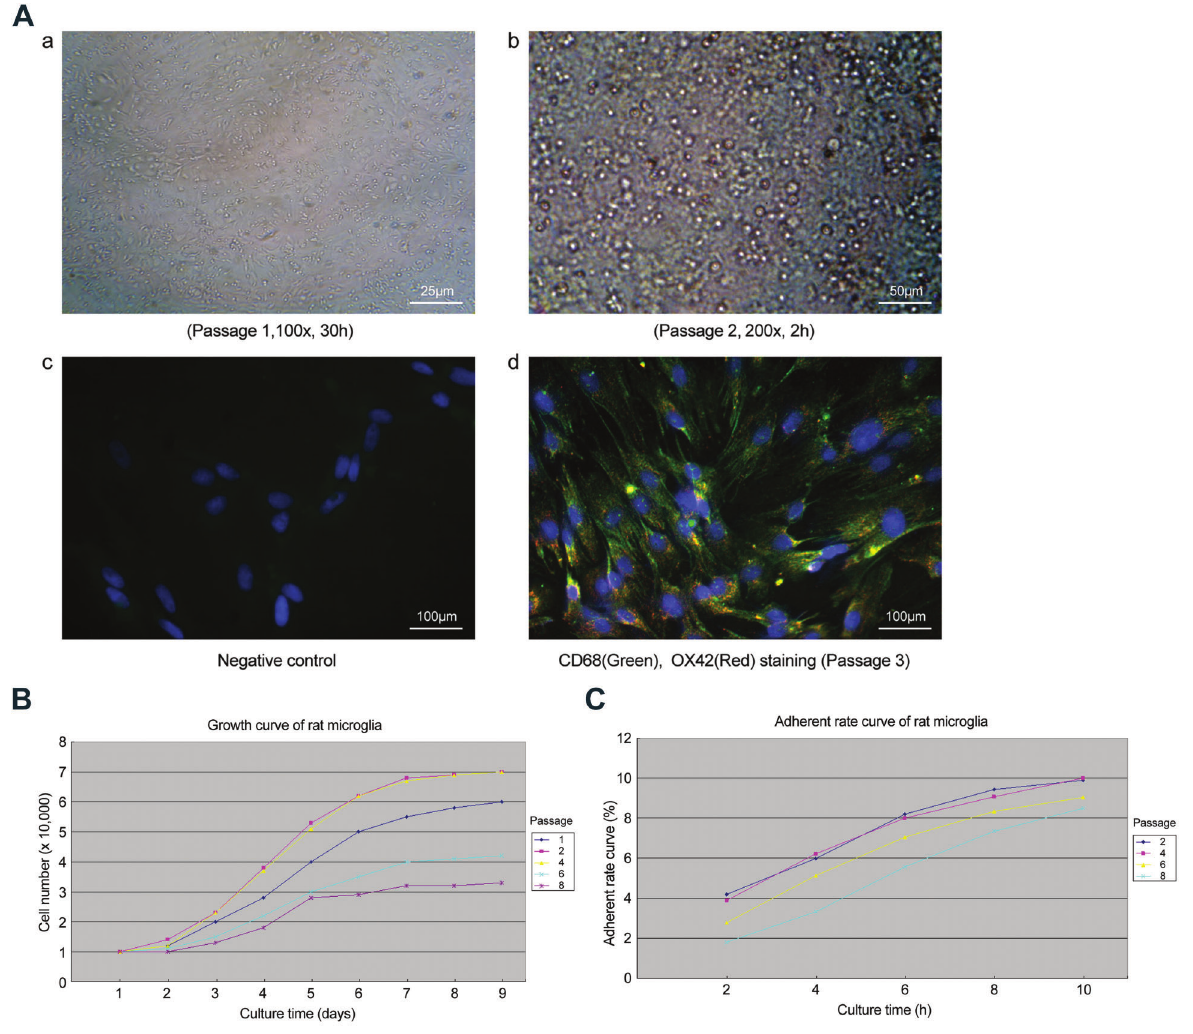
Figure 1. A . Morphology of microglia observed under a microscope ( a , b ; bars: 25 m m and 50 m m, respectively) and images of immuno- cytochemical staining for microglia stained with CD68 (green), OX42 (red) and a nuclear marker (blue) (200 (cid:1) ) in microglia ( c , d ; bars: 100 m m). B , Growth curve of different passages. C , Adherent rate curve of different